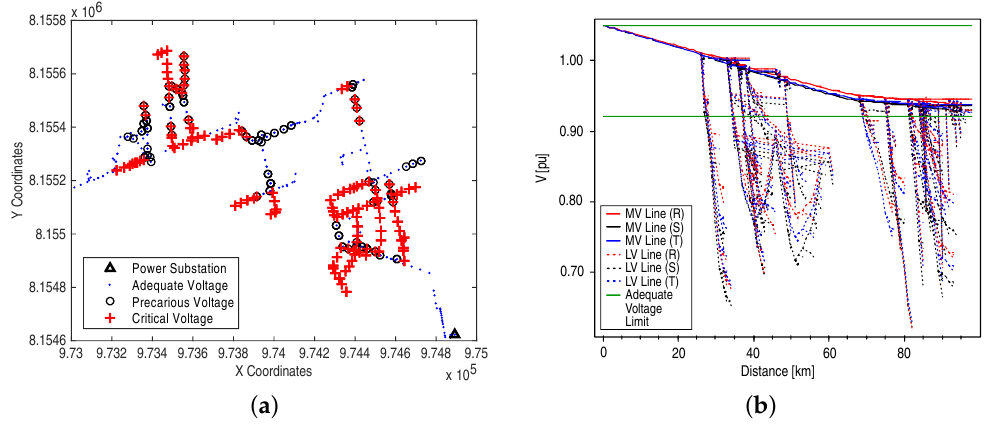
Figure 8. Feeder 14: ( a ) voltage rating and ( b ) voltage profile.